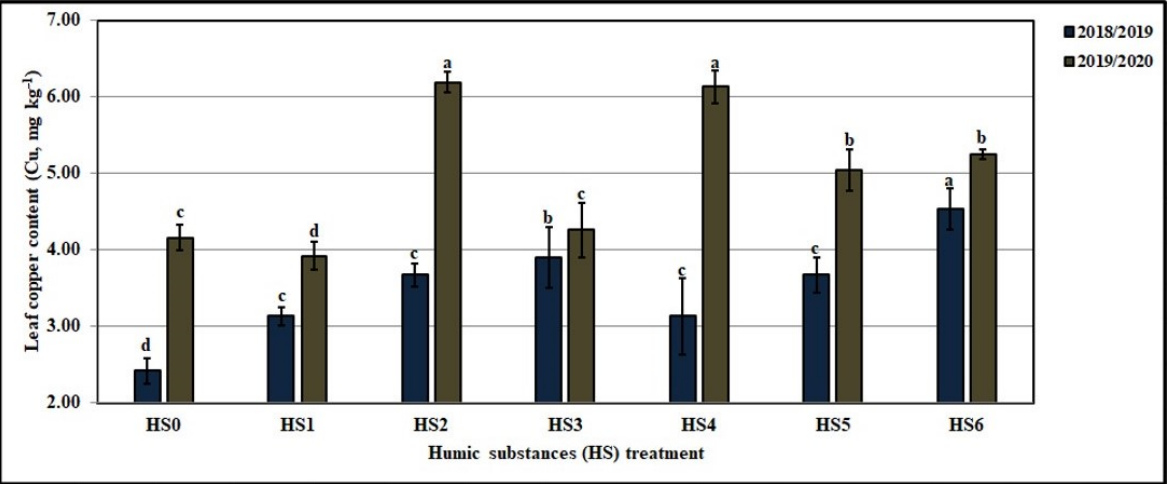
Figure 28. Influence of humic substances treatments on leaf copper contents (Cu, mg kg − 1 ) of some wheat varieties grown in clay loam soil in 2018/2019 and 2019/2020 seasons. Bars in the same years with a different letter indicate significant differences between treatments at p ≤ 0.01. HS 1, HS 2 , HS 3 represent HS applied as foliar spray at 1.0, 2.0, 4.0 g L − 1 , respectively, HS 4 , HS 5 , HS 6 represent HS applied as soil application at 5.04, 7.56, 10.08 kg ha − 1 .